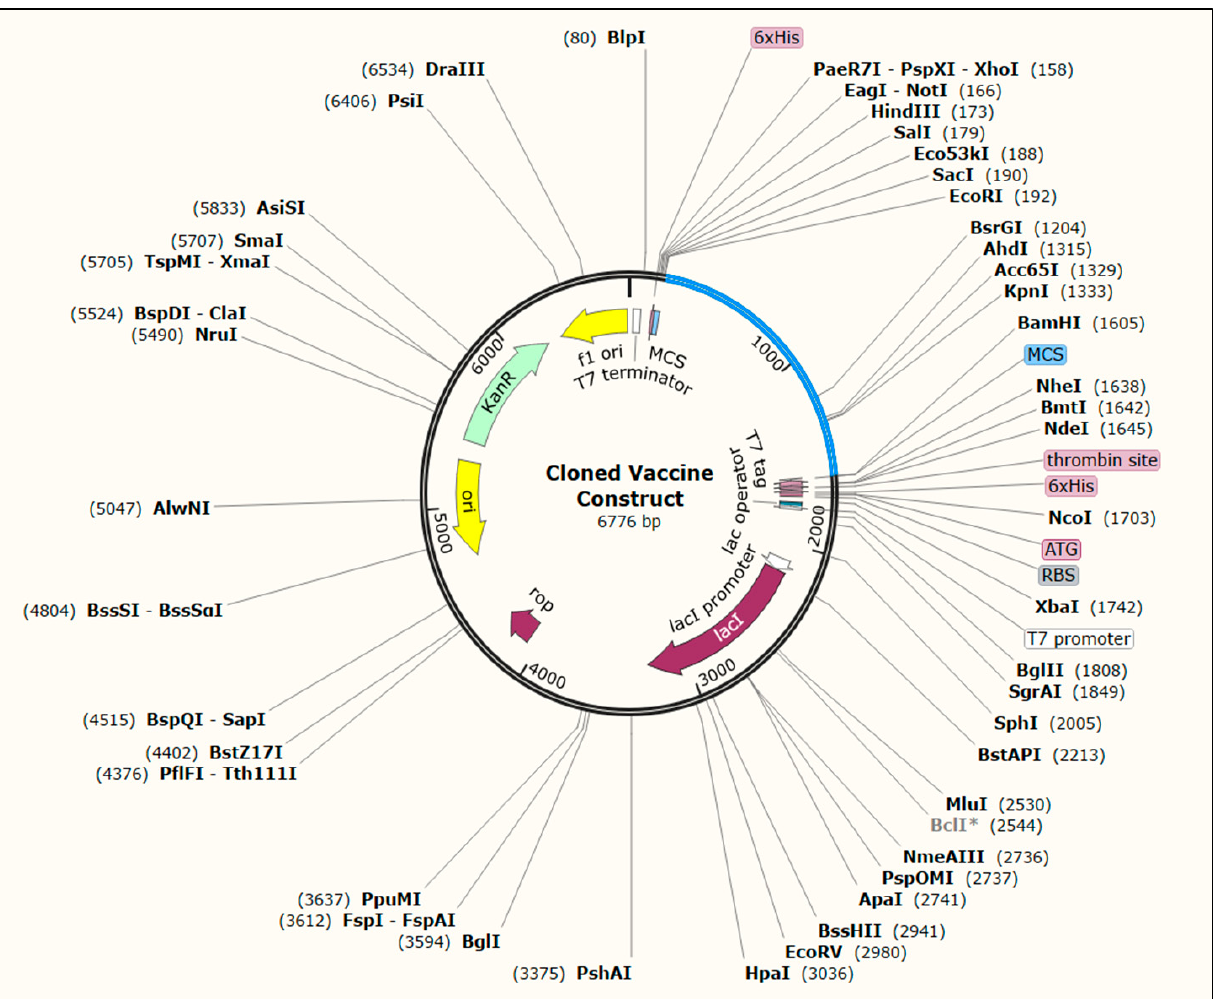
Figure 8. In silico cloning of the vaccine construct into pET28a (+) expression vector using SnapGene software. the red part represents the coding sequences of vaccine construct, and the black circle represents the vector backbone.